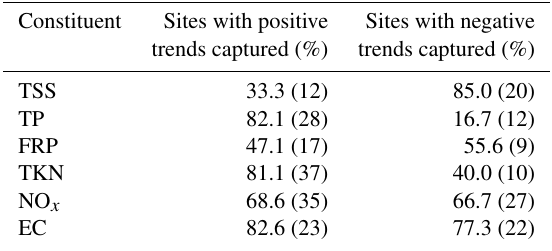
Table 4. Model ability to capture observed water quality trends across all monitoring sites for each constituent. The percentages of sites where observed positive and negative trends are captured by the model are presented separately. Values in parentheses indicate the number of sites where corresponding positive or negative trends are observed. For detailed estimation of these percentages please refer to Sect.